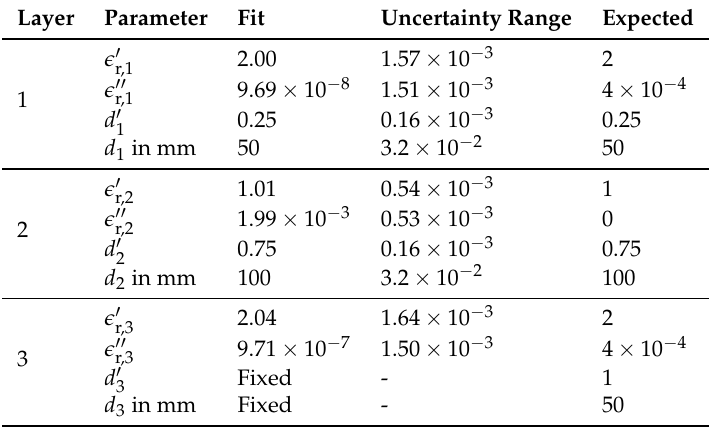
Table 3. Results of the coaxial cell reconstruction (expected values for PTFE are taken from the producer